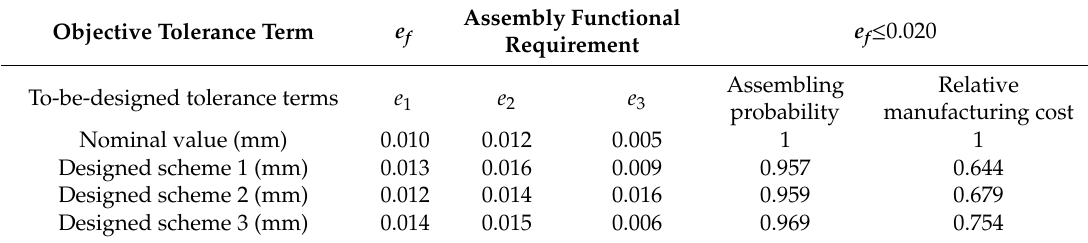
Table 3. Design requirement of the object tolerance term and the nominal and designed value of the to-be-designed tolerance terms.